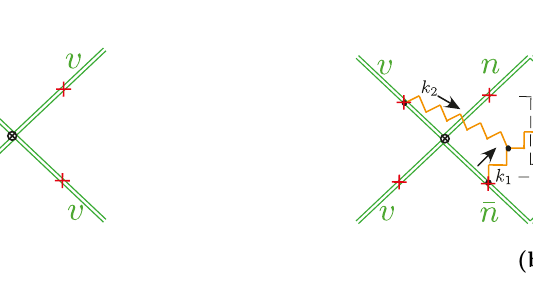
Figure 5 . Examples of real (a) and virtual (b) diagrams with a triple gauge boson vertex insertion contributing to the two loop soft function. Here the boson with momentum k 1 is at the scale M (cid:31) (1 z ), while k 2 is at the scale m . W (cid:0) presence of electroweak charged particles does not have an e(cid:11)ect, since the color structure is manifestly identical between the real and virtual